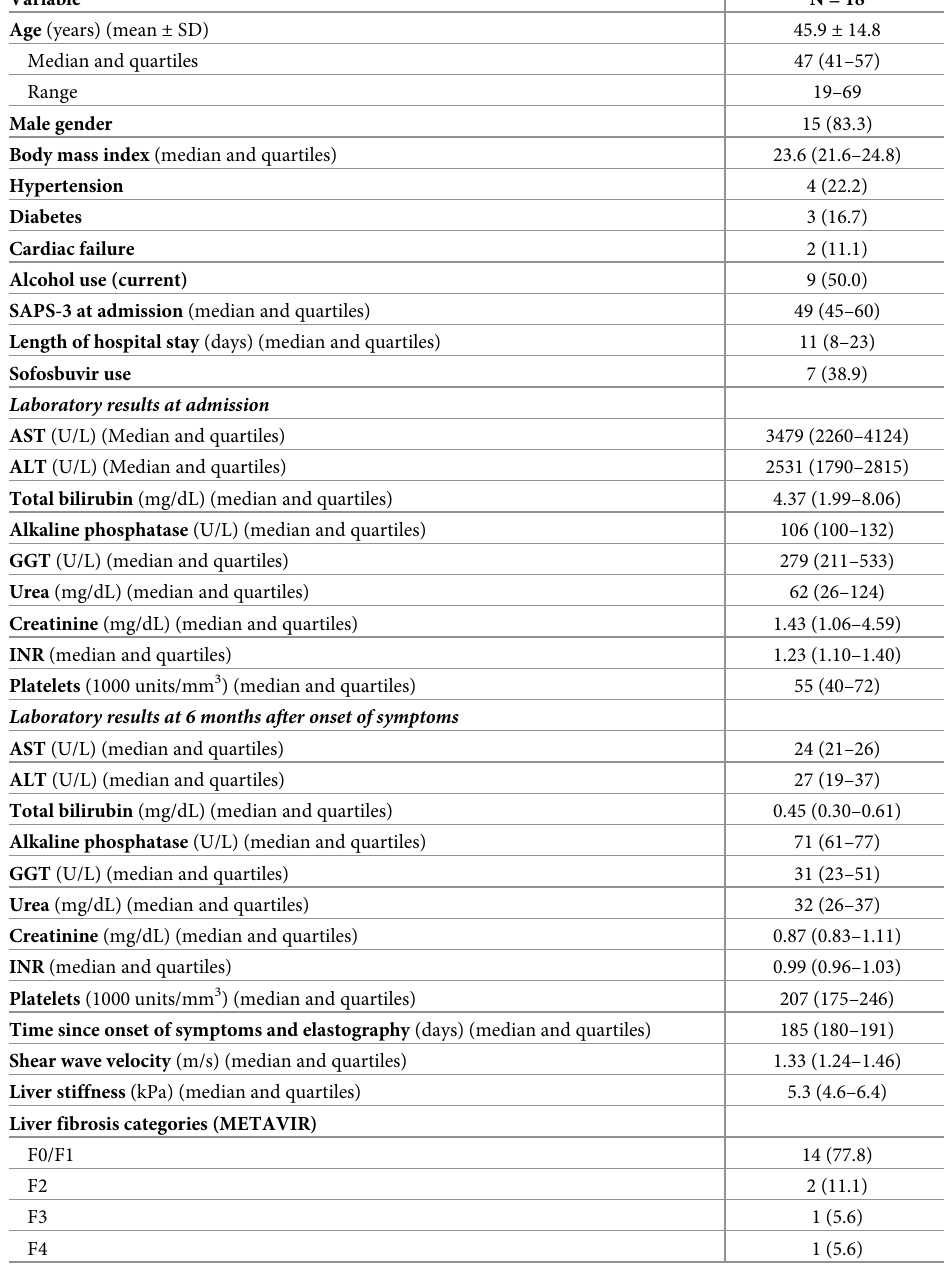
Table 1. Clinical, demographic, laboratory and elastography data of 18 patients who had severe yellow fever and were followed up to 6 months after onset of symptoms (descriptive statistics), Brazil, 2018 �